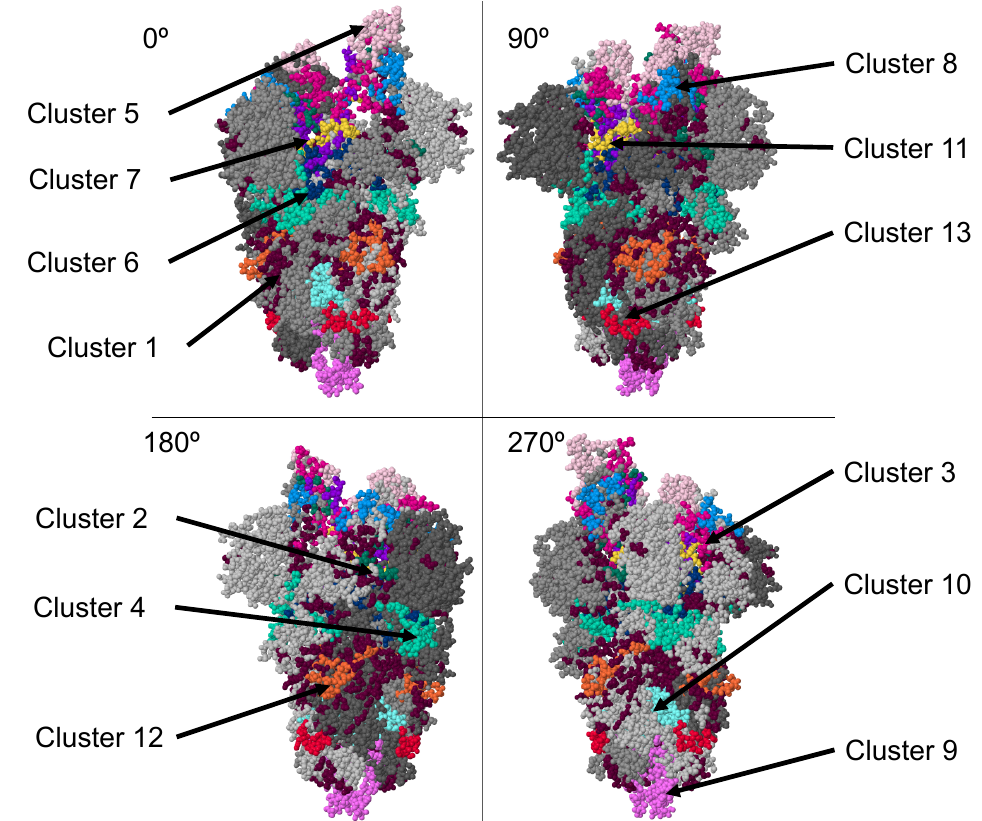
Figure 4. Clusters of amino acids identified by PepSurf surface accessible alignments of cell receptor-binding phage mimotopes on the SARS-CoV-2 spike protein using the PDB model 6VYB. Cluster 1 (dark purple), cluster 2 (green), cluster 3 (bright pink), cluster 4 (turquoise), cluster 5 (pink), cluster 6 (dark blue), cluster 7 (purple), cluster 8 (blue), cluster 9 (dark pink), cluster 10 (light blue), cluster 11 (yellow), cluster 12 (orange), and cluster 13 (red).